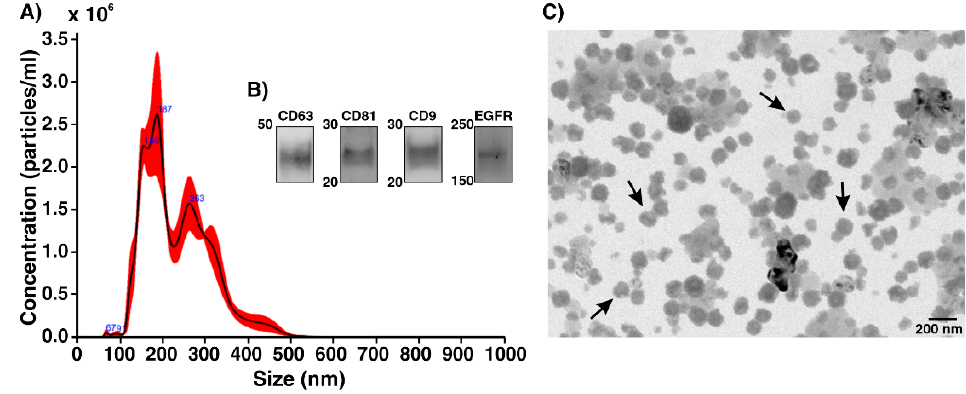
were diluted 1:5 in PBS). ( B ) For Western Blot analysis, exosomes were loaded on SDS-PAGE and immunoblotted for antibodies against tetraspanins (anti-CD9, anti-CD63, and anti-CD81) and anti- EGFR. A gel was run under non-reducing and reducing conditions with 2 × 10 8 particles: ~5 µ g. The exposure time was 80 s. ( C ) TEM images of isolated exosomes from cell culture supernatant are shown (scale bar: 200 nm). The extracted exosomes displayed perfect integrity with an average size of 100